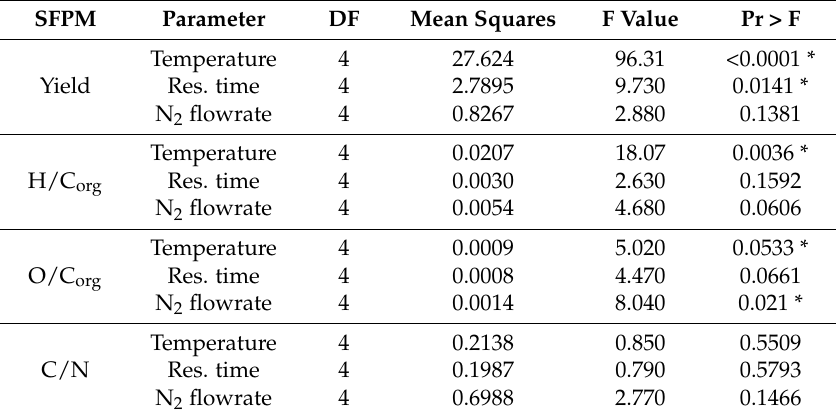
Table A6. ANOVA for the model of SFPM